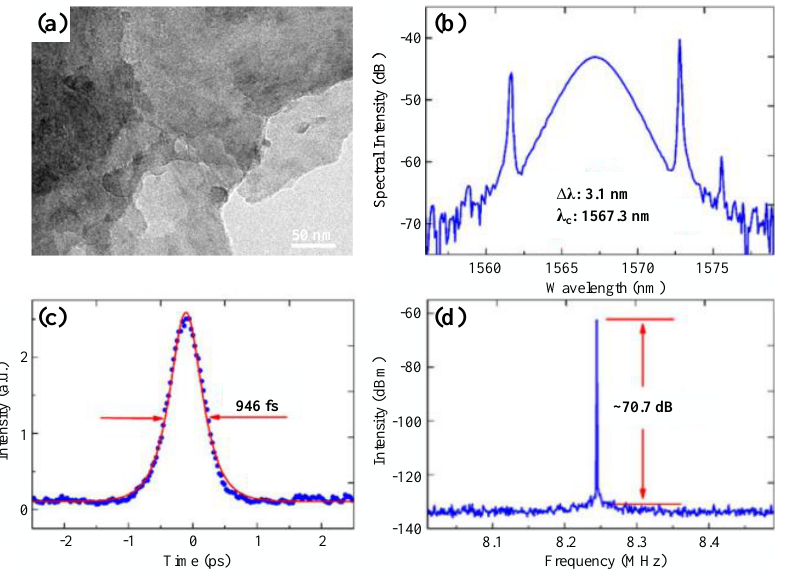
Figure 12. The experimental results of mode-locked EDFL enabled by MXene SA. ( a ) TEM image of the Ti 3 C 2 T x flakes. ( b ) Output spectrum. ( c ) Autocorrelation trace. ( d ) RF spectrum. ( a – d ) adapted from